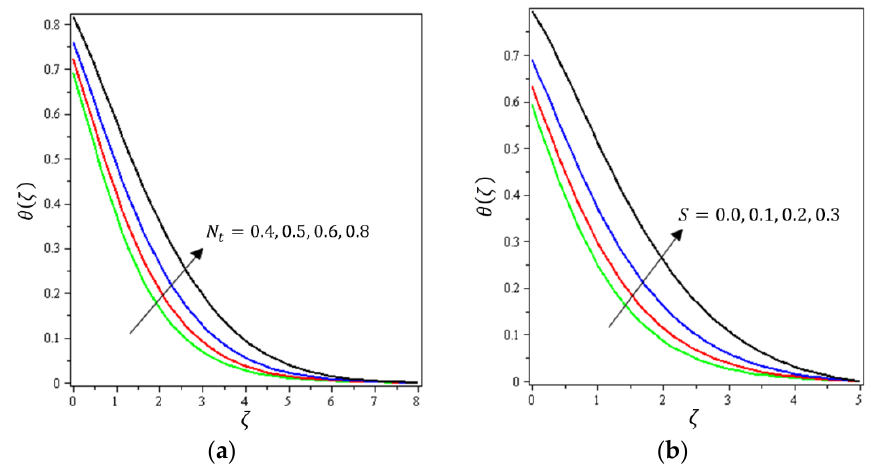
Figure 8. Influence of ( a ) thermophoretic diffusion 𝑁 (cid:3047) and ( b ) heat-generating 𝑆 on 𝜃(𝜁) .